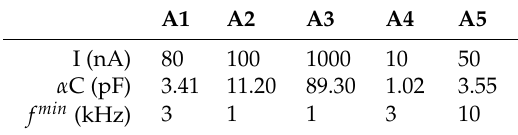
Figure 6. The steps to apply the framework to a design whose design files are available. Table 2. Always-on module parameters of the activity monitoring applications.